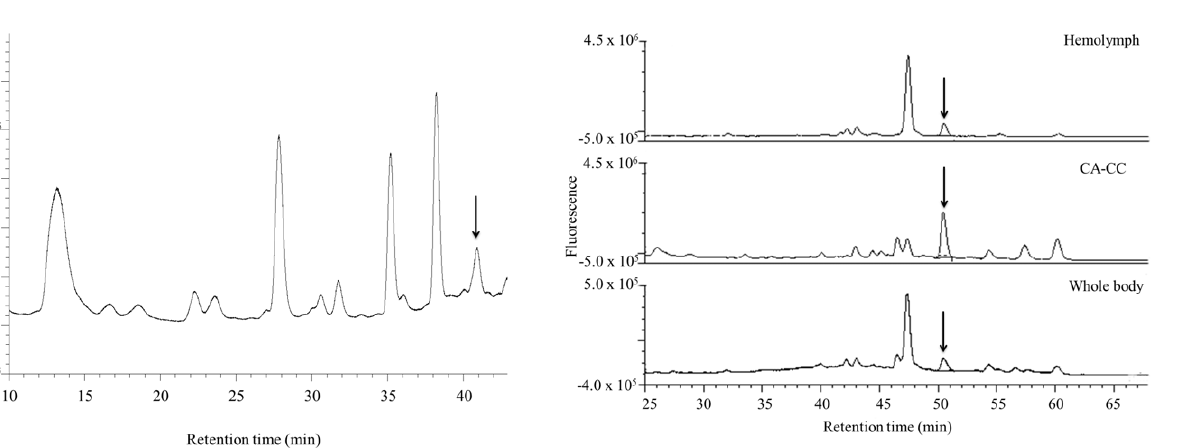
Figure 7. Detection of tagged FA in mosquito CA-CC by HPLC- FD. Extracts of CA-CC from 24 h sugar-fed females derivatized with AABD-SH. The fluorescent peak with a retention time of 40.9 min represents FA (arrow).